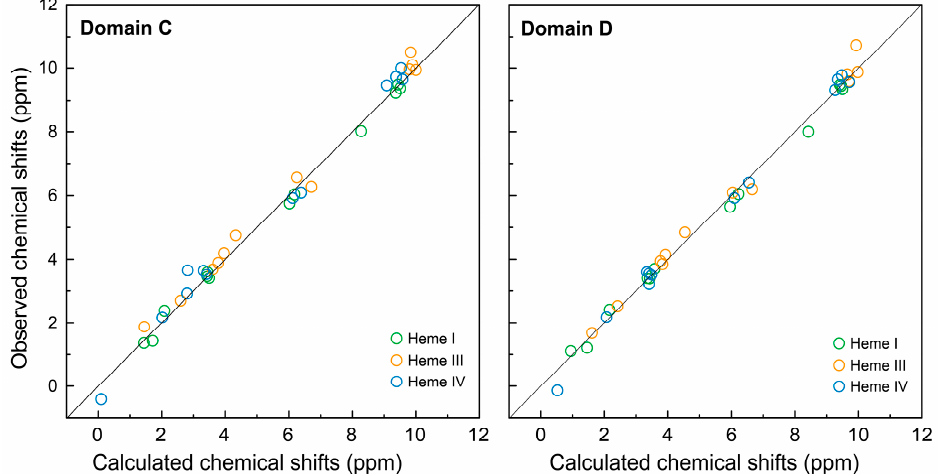
Figure 5. Comparison of observed and calculated chemical shifts of the heme protons from domains C and D. The calculated values were obtained from the crystal structure of the bi-domain CD (PDB code 3OUE [15]). The solid line has a unit slope. The RMSD values of the hemes I, III and IV are, respectively, 0.02, 0.05 and 0.07 for domain C and 0.02, 0.04 and 0.04 for domain D.